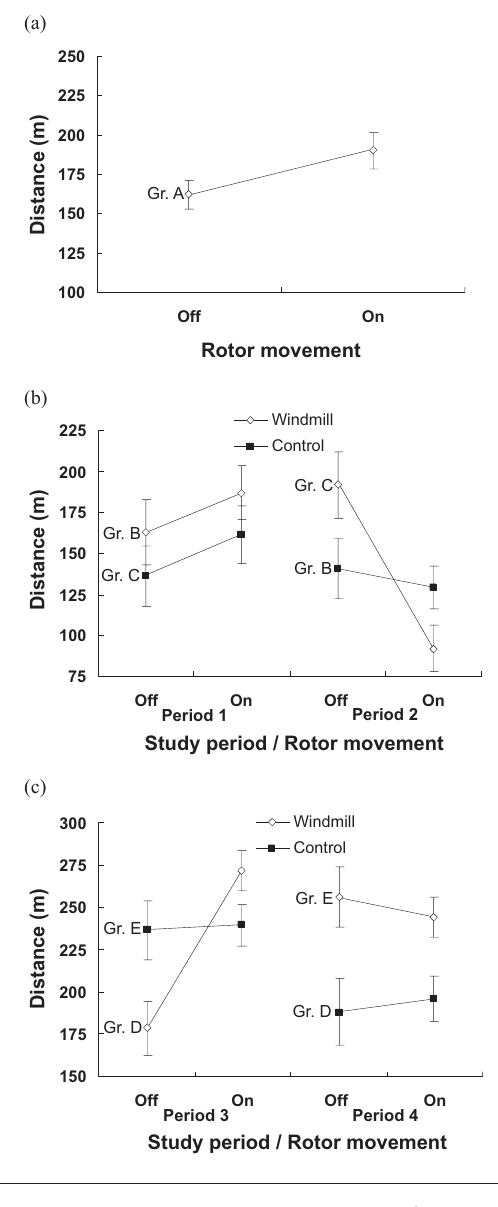
Fig. 3. Reindeer mean distance to the upper part of the enclo- sures and the wind turbine in relation to enclosure and rotor movement for (a) 1999, (b) 2000 period 1 and 2 and (c) 2000 period 3 and 4. Bars: standard error of the